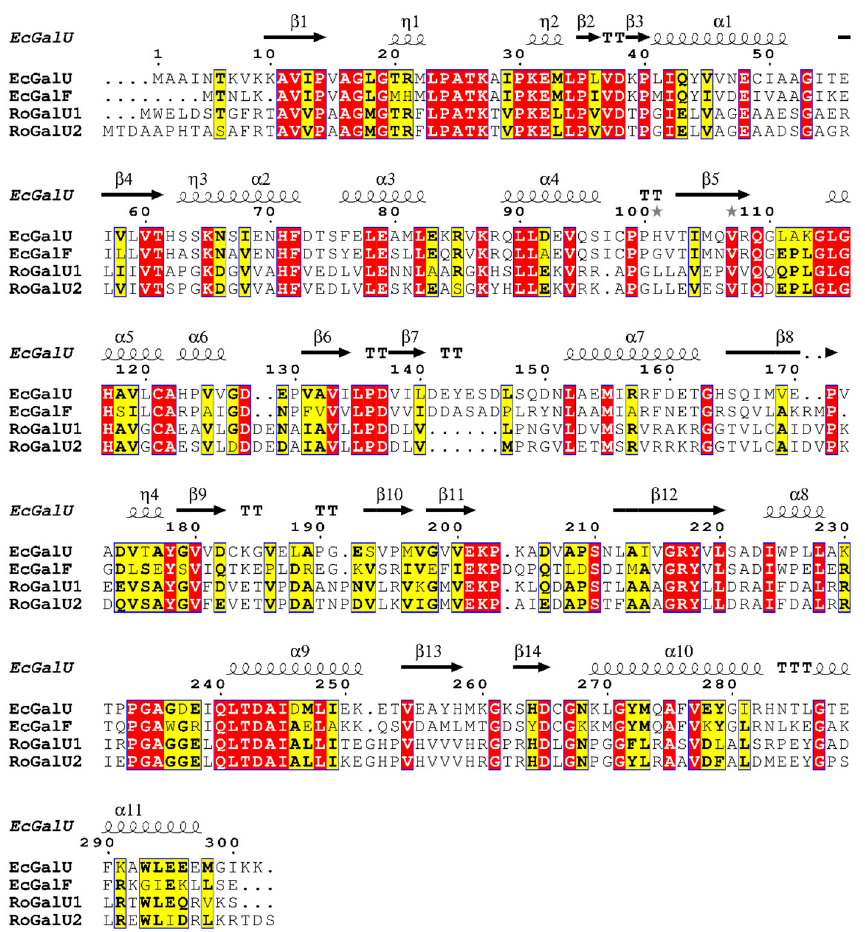
Figure 1. Alignment of Ro GalU1 and Ro GalU2 with the GalU and GalF amino acid sequences of E. coli K-12 [19], executed with the MUSCLE algorithm [45,46] in the program MEGA X [47] for multiple sequence alignment with default settings and imaged with ESPript 3.0 [48]. Conserved amino acids are color-coded. Red box with white letters: strictly identical amino acids, yellow box with black bold letters: similar amino acids, which are conserved among at least two sequences, black squiggles with α or η signs: α -helical structures, black arrows with β sign: β -sheet structures, TT : strict β -turns, TTT : strict α -turns, grey stars: residues with alternate conformations.